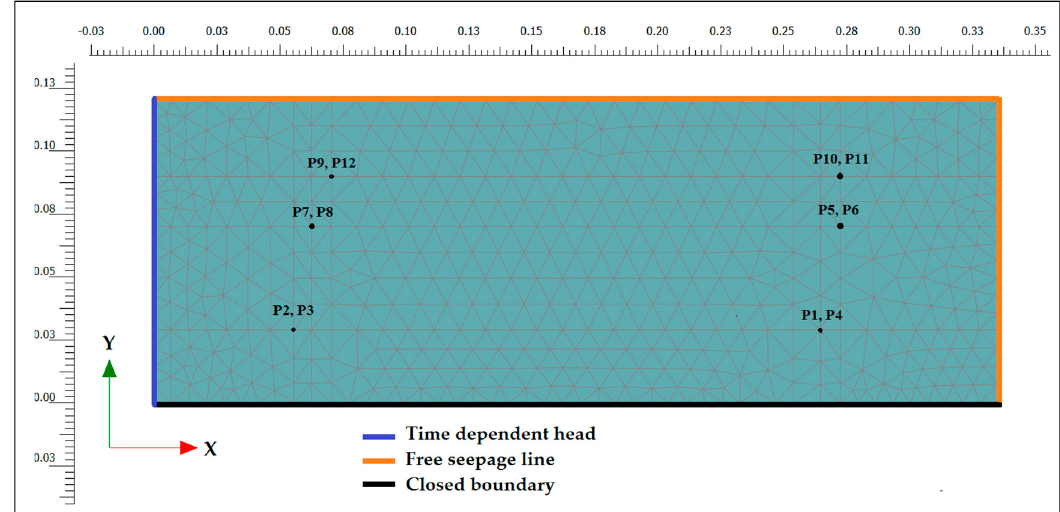
Figure 4. Discretization of the model into finite elements in the PLAXIS 2D software and definition of boundary condition with respect to the flow condition.